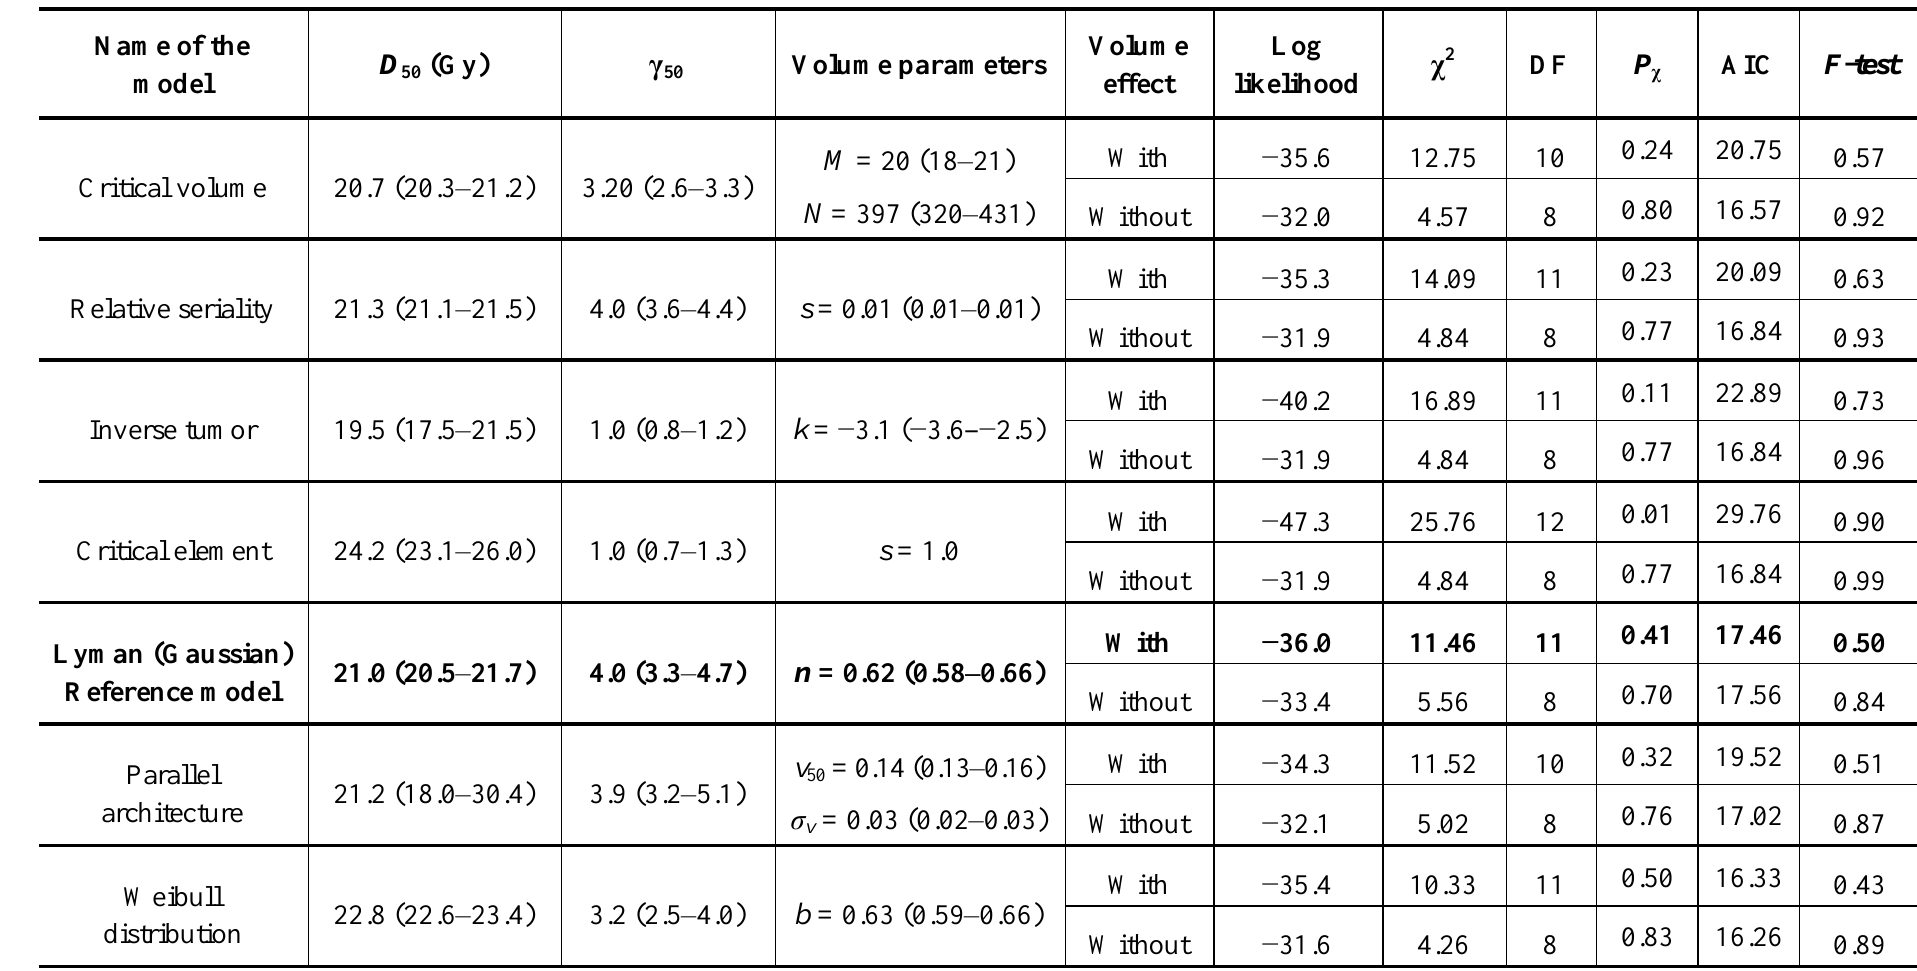
Table 3. Model parameter values for white matter necrosis. The best estimates of the parameter values are given with their 68% confidence intervals. The values of the Log-likelihood function, χ 2 , degrees-of-freedom (DF) and probability of χ 2 distribution ( P goodness-of-fit of the models to the experimental data, with and without accounting for the volume effect. The inter-comparison of the models is performed, the AIC measure and the F-test, using the Lyman model as reference (with the volume